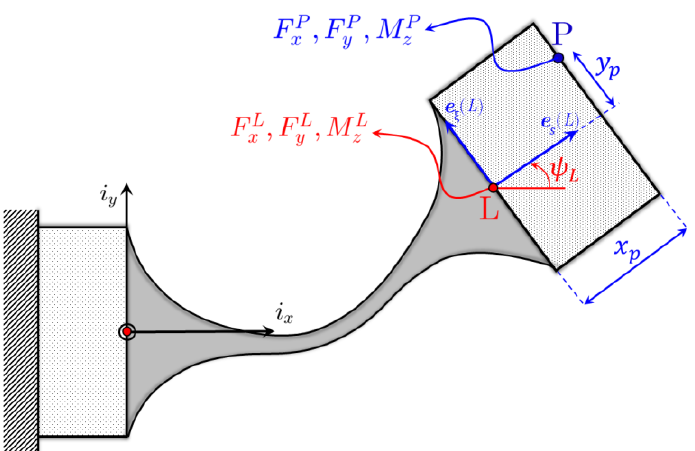
Figure 3. Flexure hinge loaded by forces and moment applied to a generic point of the rigid body connected to it.